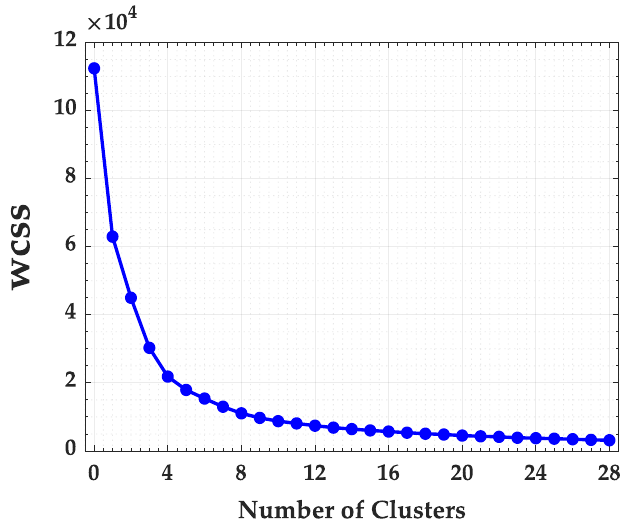
Figure 3. Within Cluster Sum of Squares (WCSS) for Maranhão